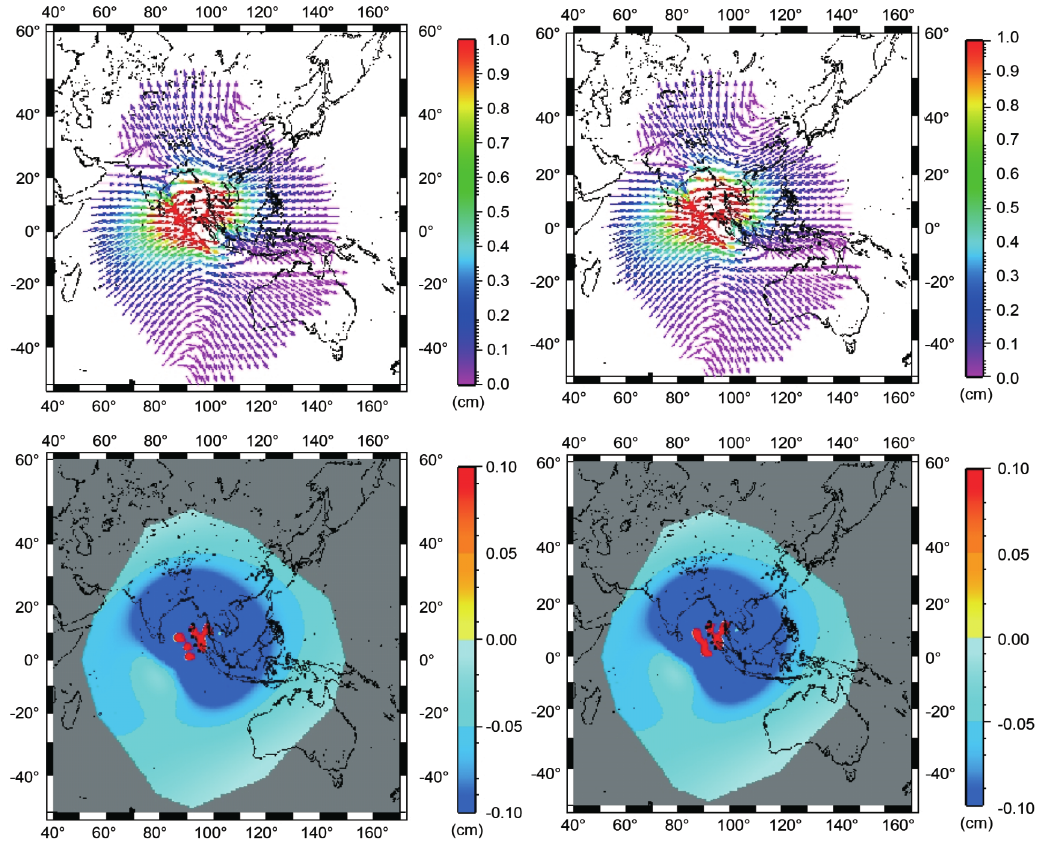
Fig. 23. Ground horizontal (vector plot on the top ) and vertical (color plot on the bottom ) displacement field calculated for the 2004 Sumatra earthquake with a line source (1D)